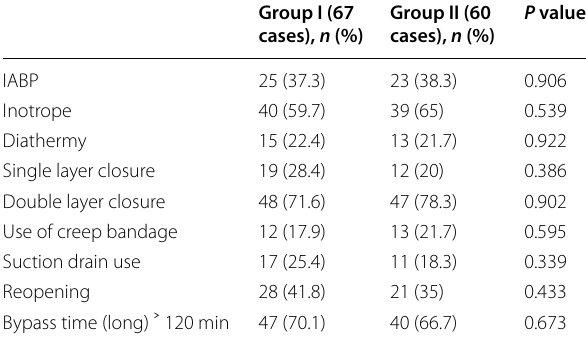
Table 3 Intraoperative and postoperative factors